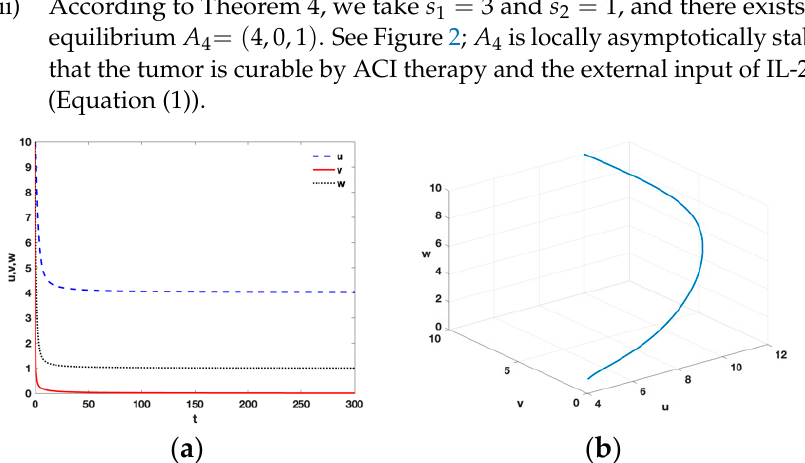
Figure 2. Time series ( a ) and phase diagram ( b ) of equilibrium point A 4 = ( 4,0,1 ) with a = 0.9, m 1 = 1, k 1 = 0.5, b = 1, c = 3, s 1 = 3, d = 2.5, k 2 = 1, m 2 = 1, s 2 = 1, and β =